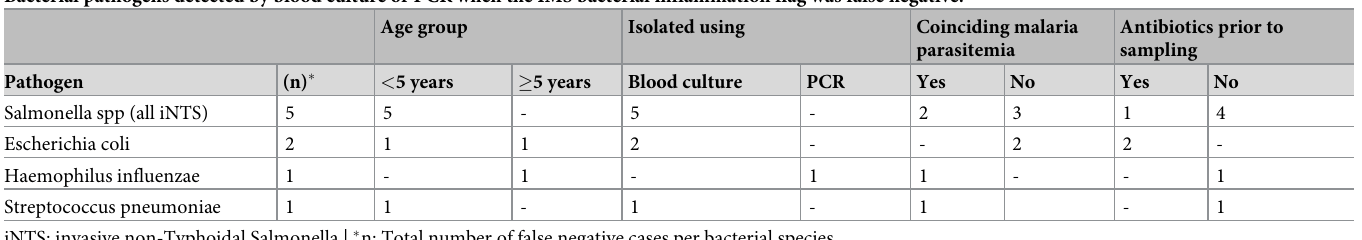
Table 4. False negative flagging of IMS in cases with bacteremia (upper part) and false positive IMS flagging in cases of bacterial infection (lower part), among patients of all ages. Bacterial pathogens detected by blood culture or PCR when the IMS bacterial inflammation flag was false negative.